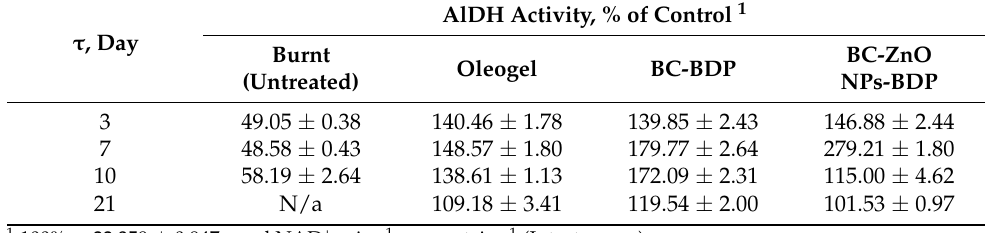
Table 6. The activity of aldehyde dehydrogenase under the action of the studied drugs (% of control), n = 3, p <